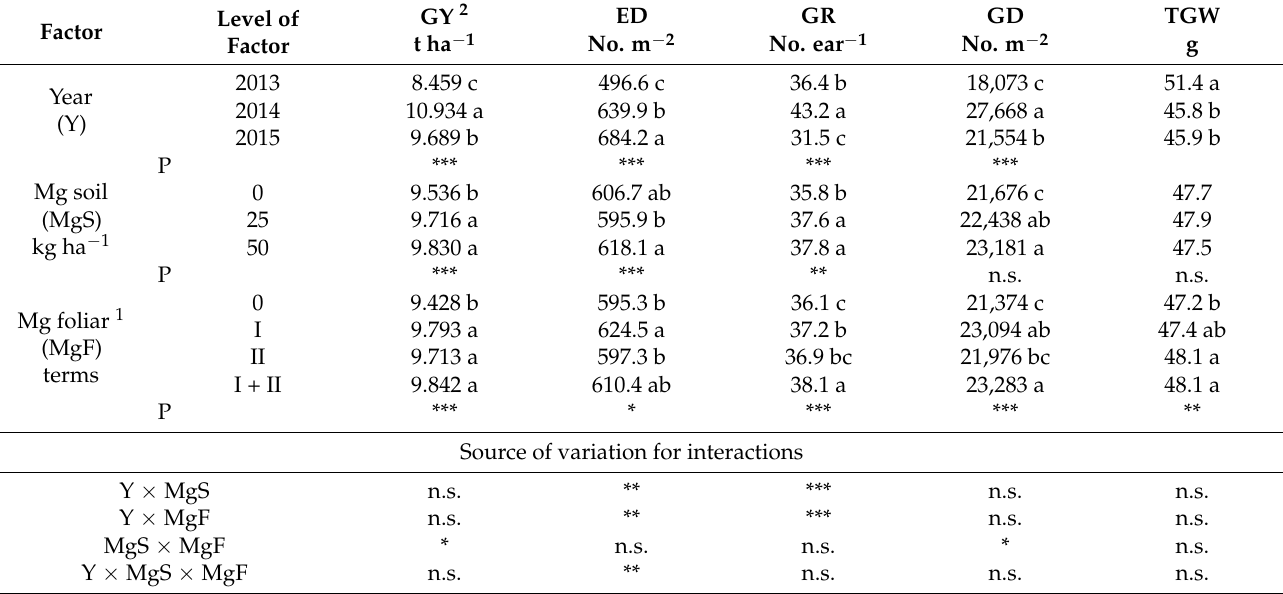
Table 3. Statistical evaluation of factors affecting in-season yields of winter wheat and yield basic